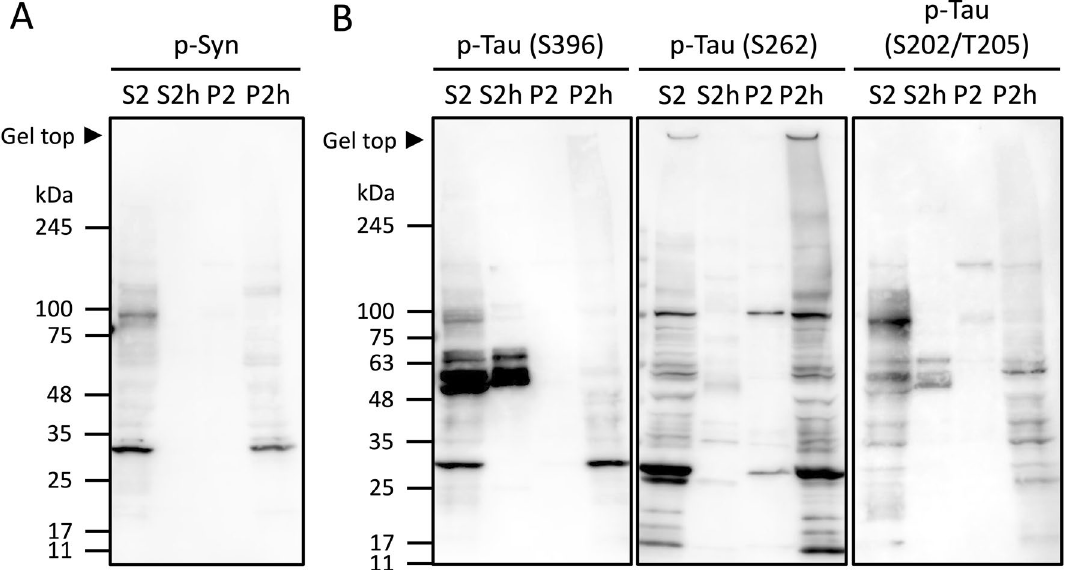
Figure 3. Western blot analysis of phosphorylated proteins. Western blot of each fraction stained with the antibodies to p-syn (A) , p-tau S396, p-tau S262 and p-tau S202/T205 (AT8) (B)